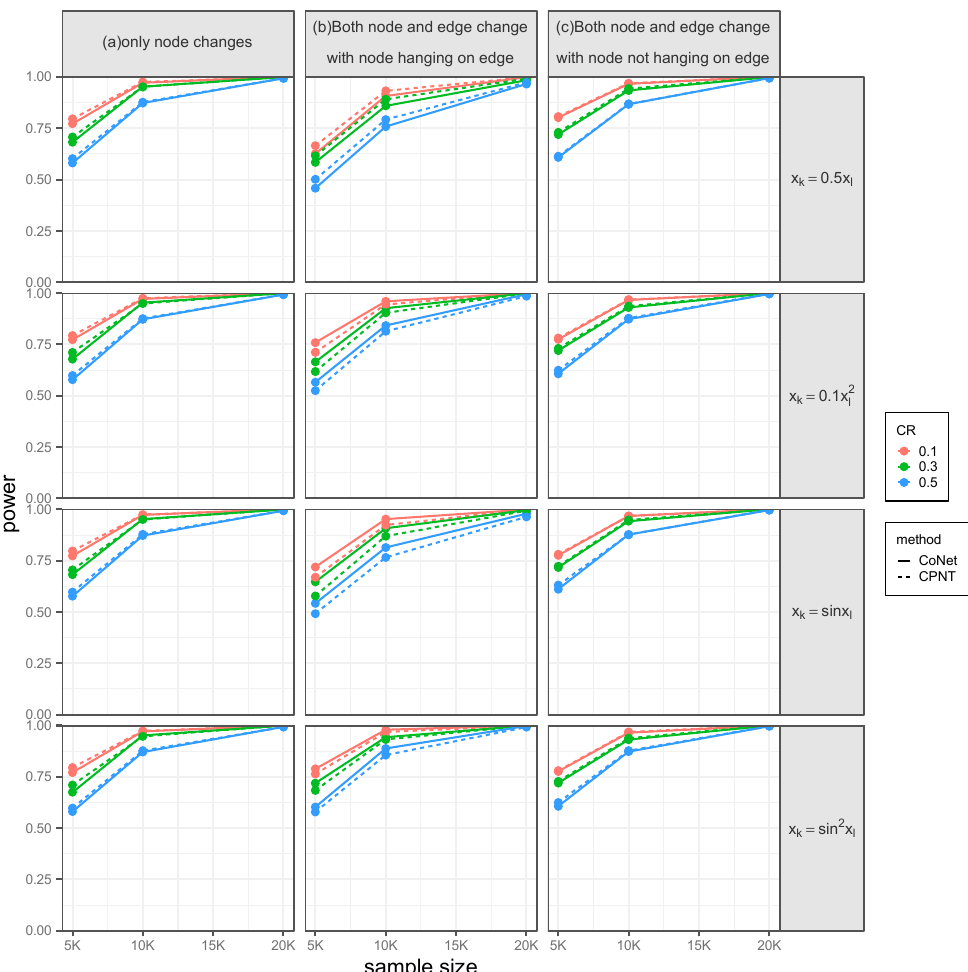
Figure 2. The power for testing the effect of the node on the survival phenotype under the setting that the effecting node is pre-specified, with the SNP effect obtained from the DPR model. Simulations were conducted with four different between-node correlation patterns (the combination of sine and quadratic, sine, quadratic, and linear) and three different censoring rates (0.1, 0.3, and 0.5). ( a ) Only a node has an effect. ( b ) Both node and edge have effects, with the effecting node hanging on the edge. ( c ) Both node and edge have effects, with the effecting node not hanging on the edge.